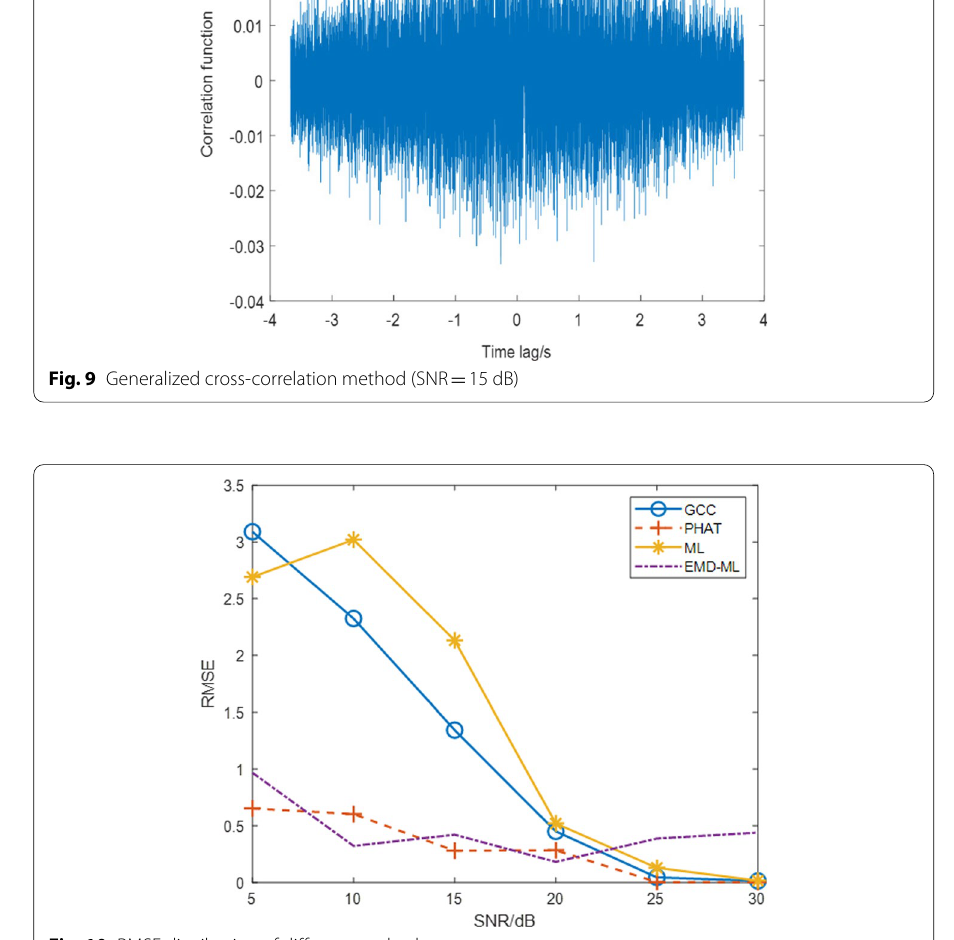
Fig. 10 RMSE distribution of different